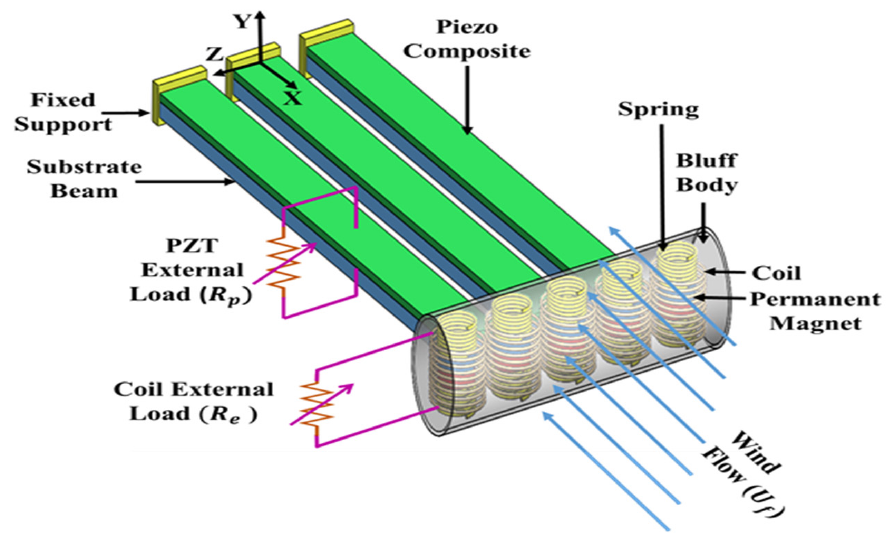
Figure 1. The conceptual design of a multi-hybrid energy harvester .